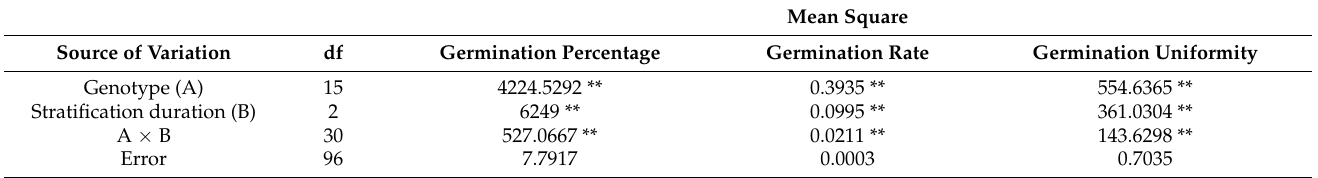
Table 2. Analysis of variance for effect of genotype and stratification duration on kiwifruit seed germination characteristics. Mean Square Source of Variation df Germination Percentage Germination